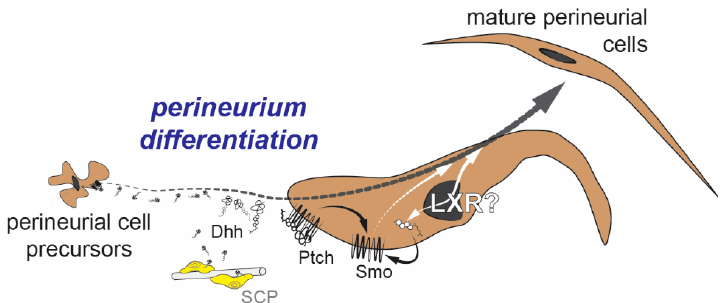
Figure 4. Development of perineurial cells and Desert Hedgehog (Dhh) signaling. Dhh, secreted by Schwann Cell Precursors (SCP), interacts with the Patched (PTCH) receptor at the surface of the perineurial cell precursors. It allows Smoothened (SMO) to be activated to trigger a differentiation program. To be functional, SMO also requires the presence of endogenous cholesterols and oxysterol molecules that are also potent LXR ligands. Therefore, a functional dialogue between these two signaling pathways can be speculated.